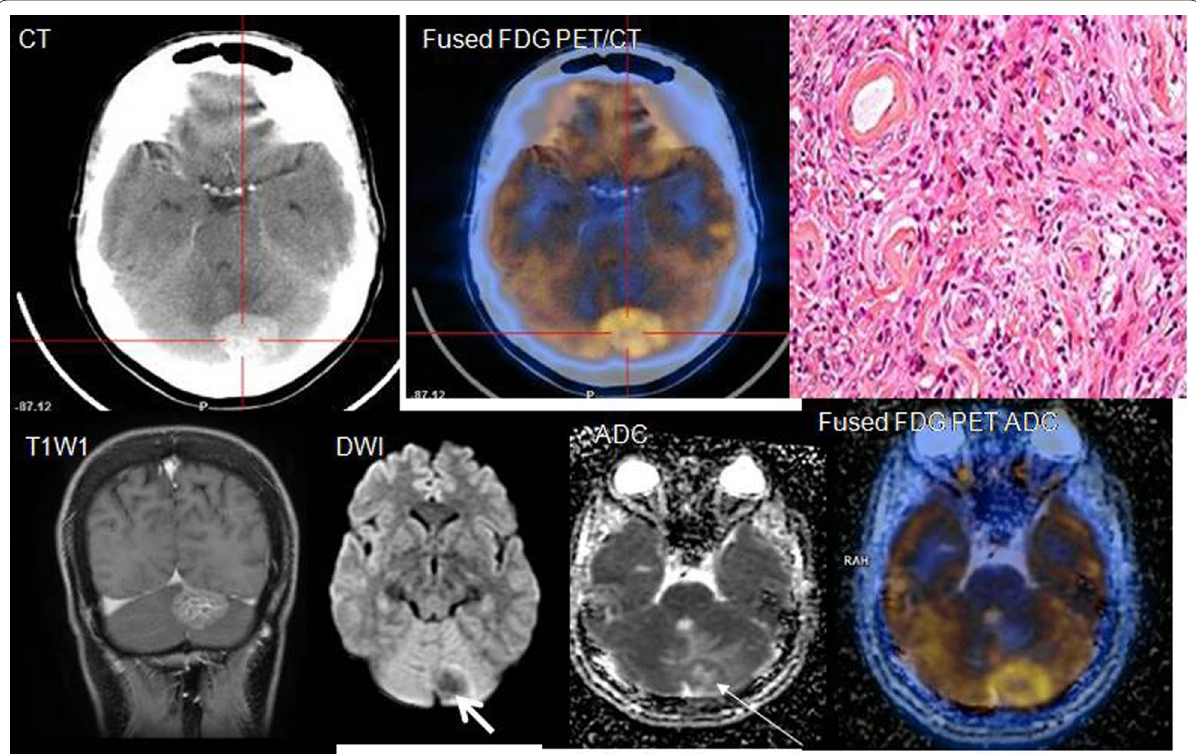
Fig. 1 Top row, right to left: transaxial brain CECT, fused FDG PET/CT transaxial brain image and histology of papillary meningioma. Bottom row: coronal MR (T1W1), DWI, ADC and fused (FDG PET/MR with ADC map) images. Post-contrast CT showed homogenous enhancement of extra-axial lesion (crosshair). Fused FDG PET/CT image showed increased FDG uptake consistent with the cerebellar lesion. Histopathology was conclusive and revealed characteristic perivascular pseudopapillary pattern suggesting papillary meningioma (WHO grade III). T1W1 image confirms homogenous enhancement of the lesion. DWI revealed isointense to slight hypointense lesion with predominantly low signal (thick arrow) and scattered hyperintensities (thin arrow) on ADC map unlike other atypical meningioma. Surrounding perilesional edema was noted. An MRI imaging diagnosis of solitary brain metastasis was made. But CT raised possibility of extra-axial cerebellar